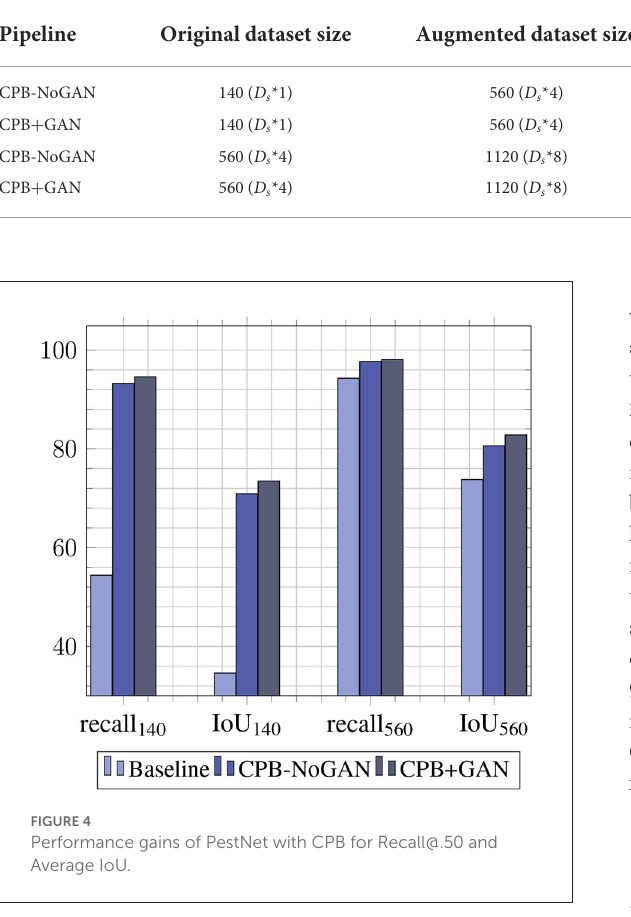
of three artificially-generated sets of 60 images each. The first two sets were generated using the CPB-NoGAN pipeline, from 20 original whitefly objects, at a lower-resolution of 512 × 512 pixels, and a higher-resolution of 1,024 × 1,024 pixels. The third set was generated using the CPB+GAN pipeline, from 20 original whitefly objects augmented to 60, at the resolution of 512 × 512 pixels for the images. The 512 × 512 resolution corresponds to the models’ resolution for a fair comparison, but at this size the anomalies in the synthetic data are more difficult to detect for